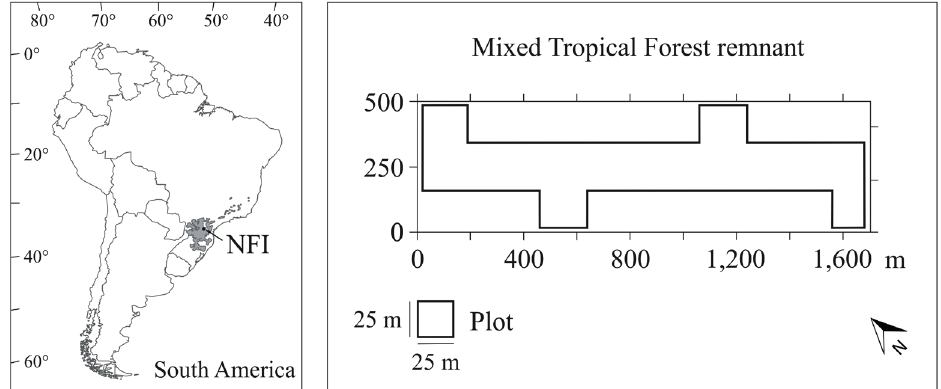
Figure 1 - Mixed tropical forest natural distribution and National Forest of Irati (NFI) in the Southern region of Brazil, South